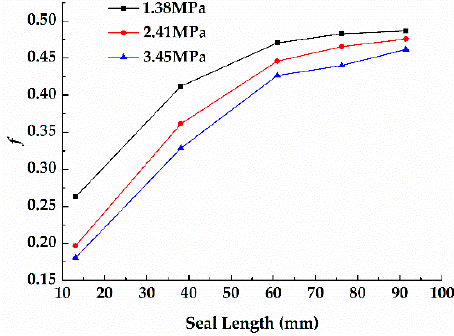
Figure 14. Whirl frequency ratio as function of the seal length.